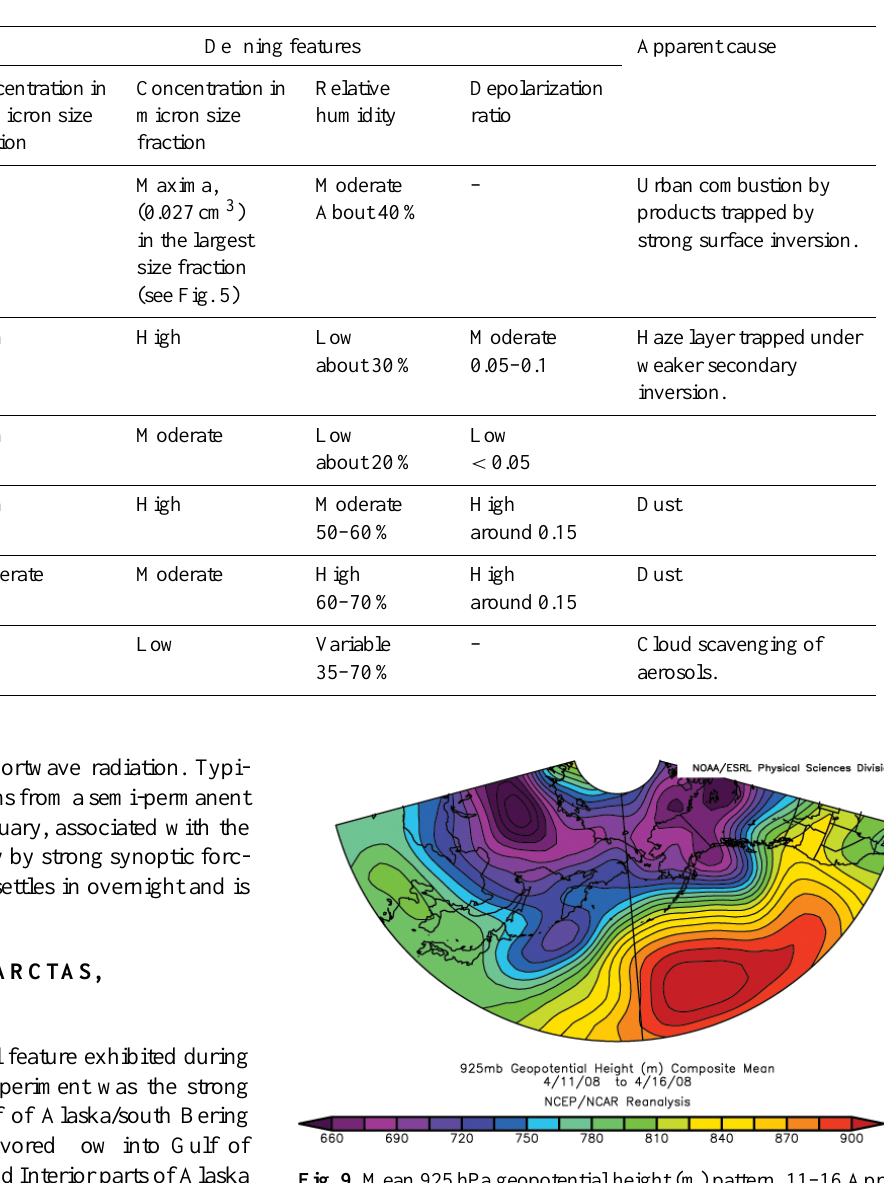
Table 1. Layers present in the lowest 4.1km of the atmosphere for the Fairbanks area, 22:00UTC, 19 April 2008, as derived from OPC observations.